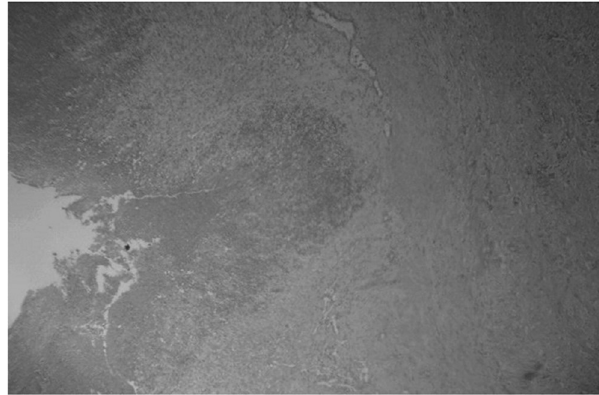
Figure 4 - A giant thrombosed venous aneurysm in the calf. Histological analysis showed vascular dilatation and luminal